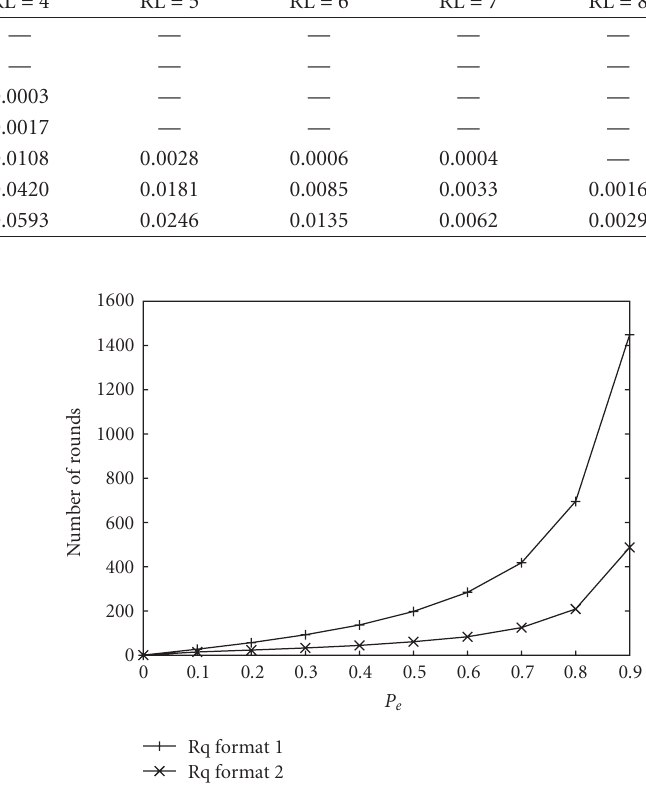
Figure 13: Error run length distribution under heavy losses incurred by interference.